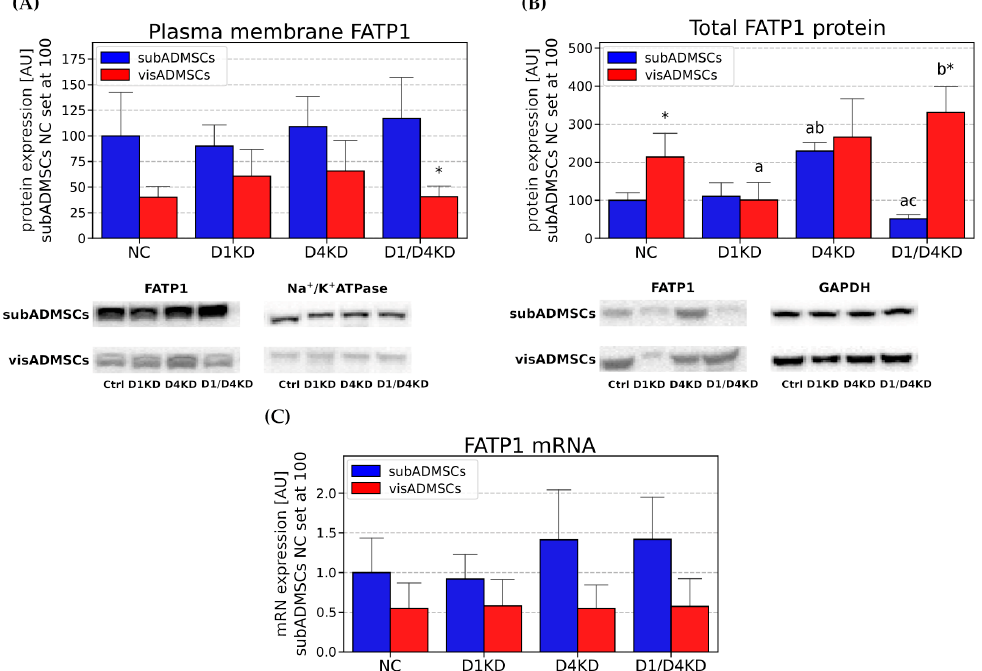
Figure 8. Plasma membrane ( A ), total protein ( B ) and mRNA ( C ) content of FATP1 in TBC1D1- and/or TBC1D4-deficient adipocytes. Bars and whiskers represent the mean and SD respectively. Number of patients equals four (measurements taken in duplicate). Values are expressed in arbitrary units; the mean in subADMSCs' negative control was set at 100. Representative Western blot images are shown. a—difference versus NC ( p < 0.05); b—difference versus D1KD ( p < 0.05); c—difference versus D4KD ( p < 0.05); * p < 0.05 significantly different from visADMSCs. Designation of the groups: NC— negative control containing non-targeting siRNA fragment; D1KD—knockdown of TBC1D1 ; D4KD—knockdown of